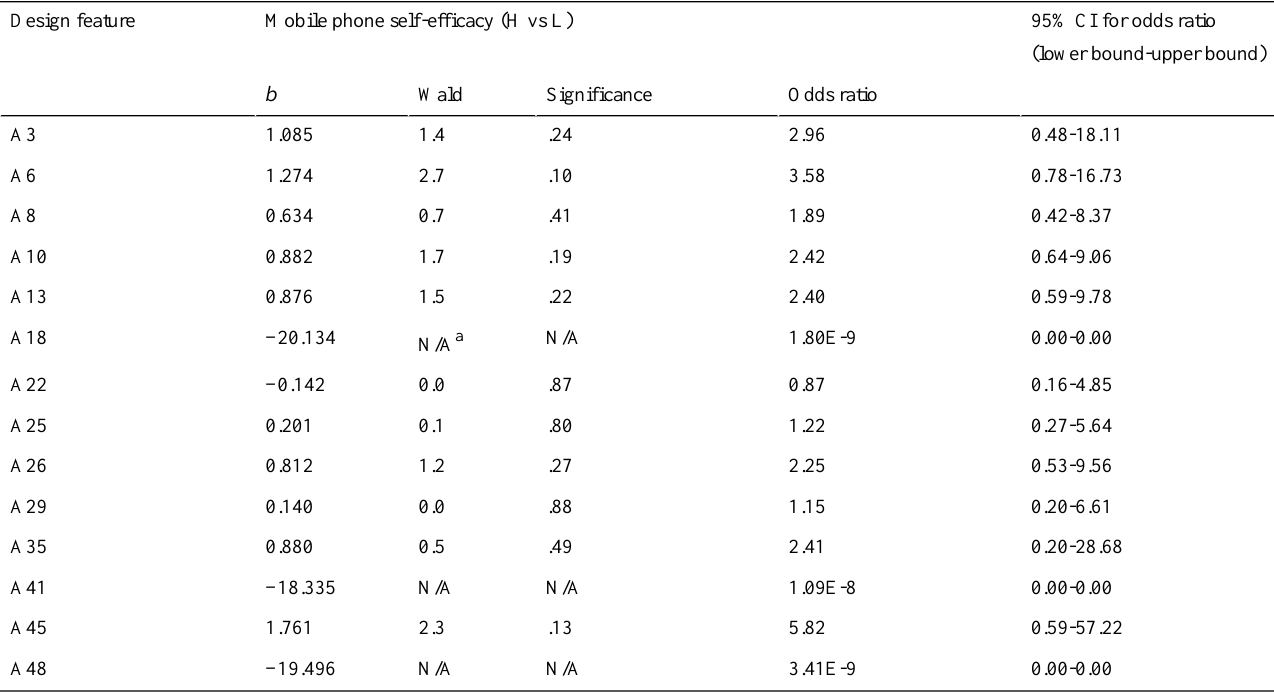
Table 14. Parameter estimates of change of mobile phone self-efficacy (MPSE) from low to high ( must-be over indifferent